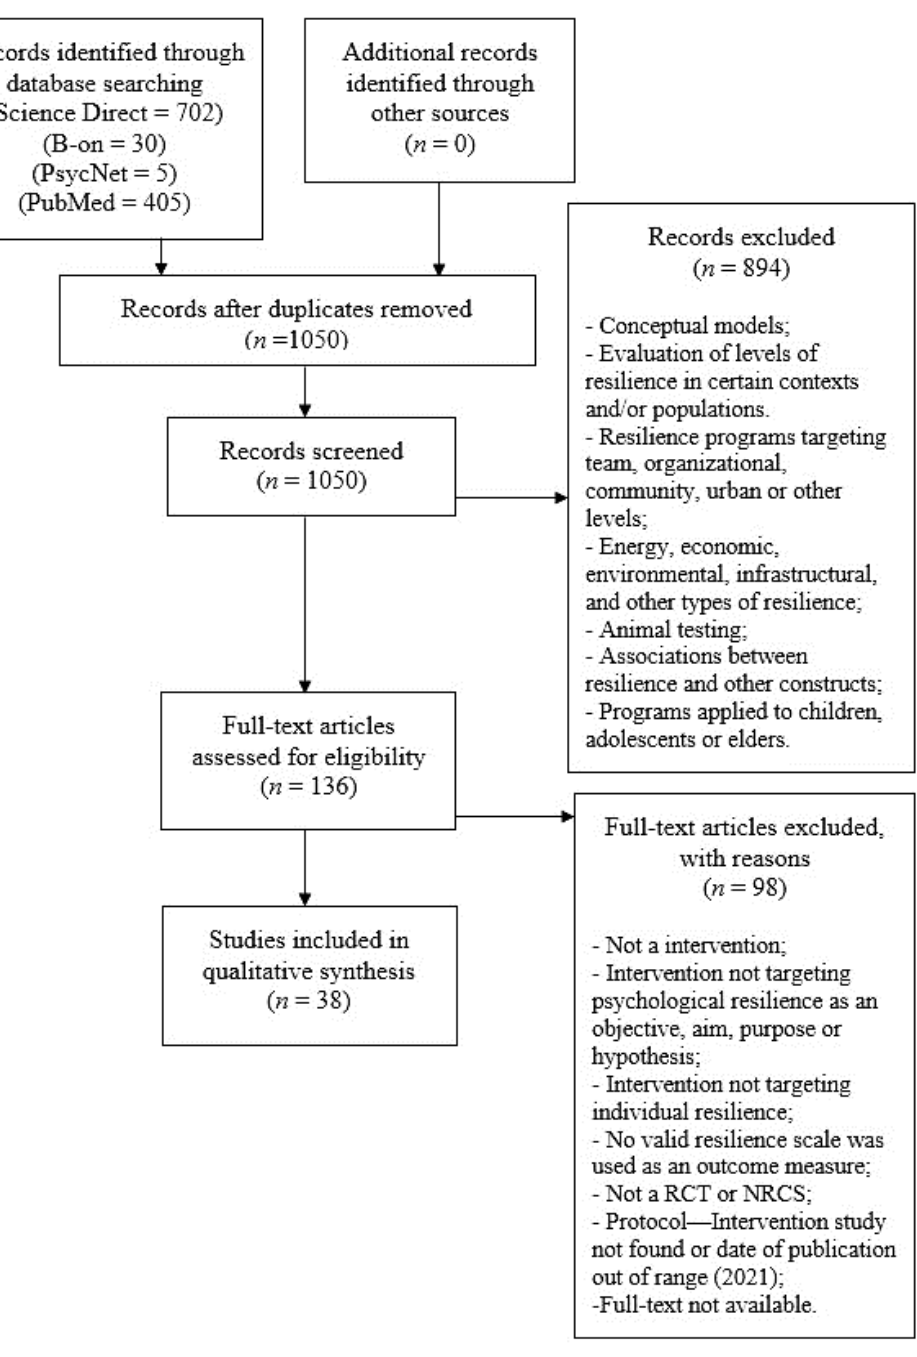
Figure 2. Preferred Reporting Items for Systematic Reviews and Meta-Analyses (PRISMA) flow chart. Adapted from Moher et al. [64].